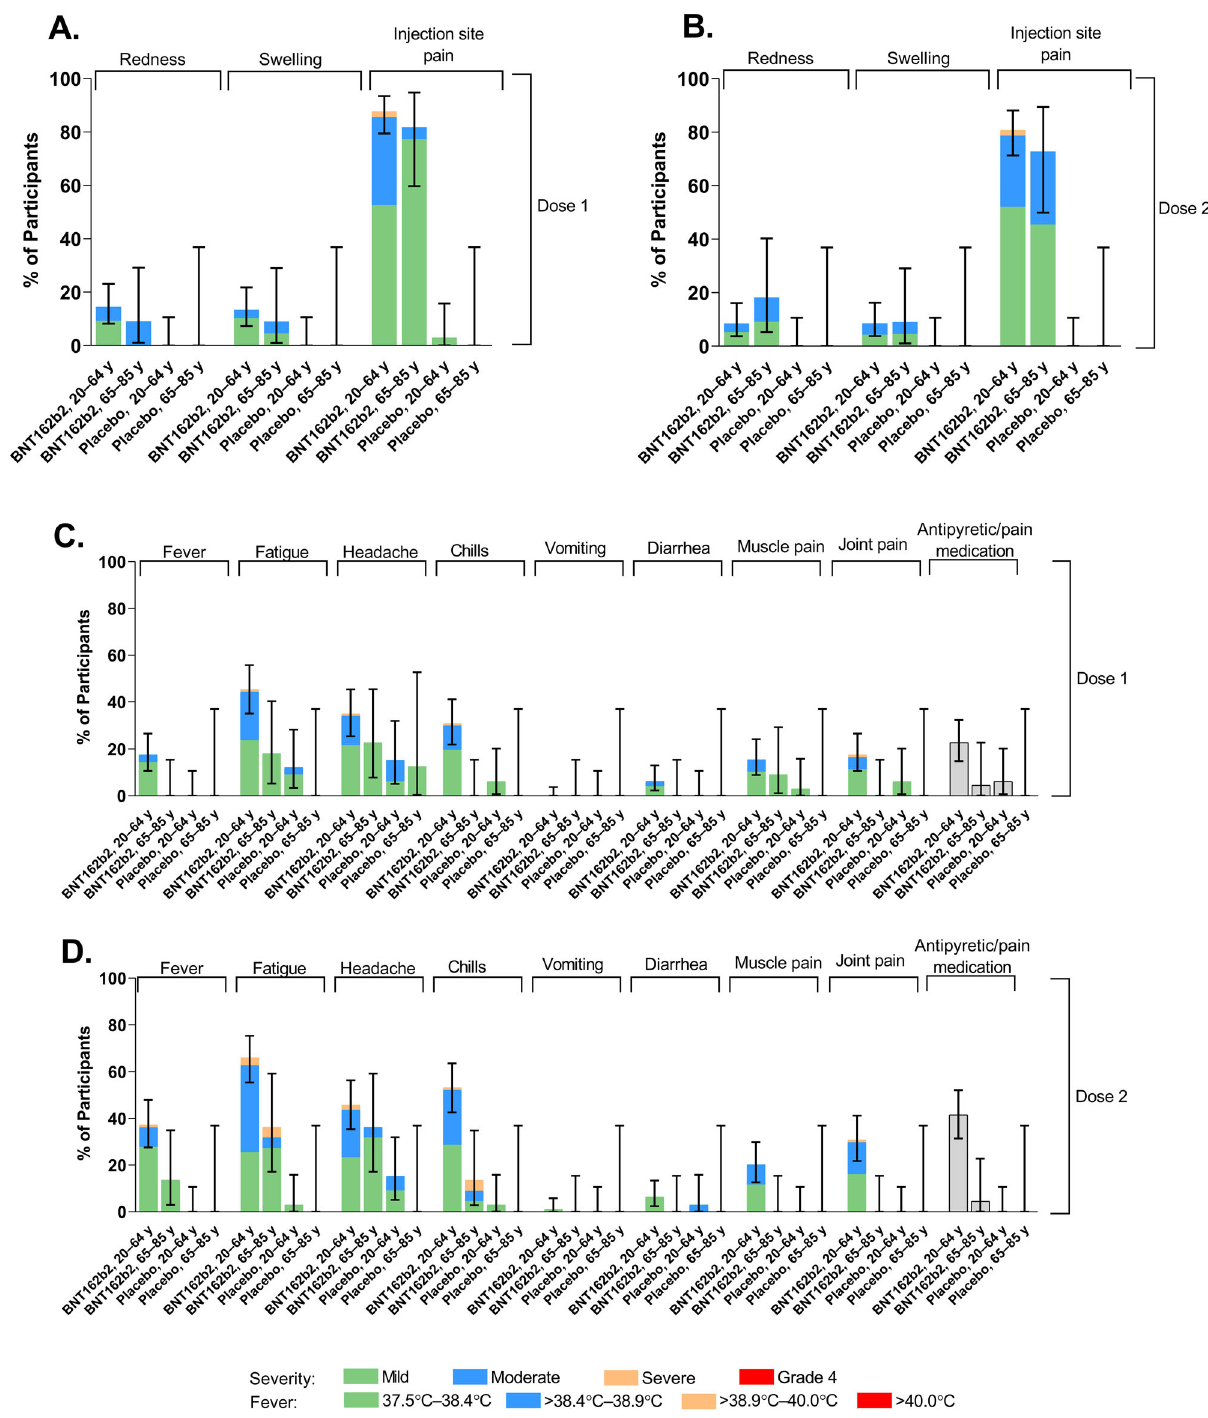
Fig. 2 Local reactions and systemic events reported within 7 days after administration of BNT162b2 or placebo in participants 20 – 64 years of age and 65 – 85 years of age. A , B Local reactions after doses 1 and 2, respectively. C , D Systemic events after doses 1 and 2, respectively. Results are for the safety population (20 – 64 years of age: n = 97 for BNT162b2, and n = 33 for placebo; 65 – 85 years of age: n = 22 for BNT162b2, and n = 8 for placebo). Pain at injection site was graded as mild (does not interfere with activity), moderate (interferes with activity), severe (prevents daily activity), or grade 4 (led to emergency department visit or hospitalization). Redness and swelling were graded as mild (>2.0 – 5.0 cm in diameter), moderate (>5.0 – 10.0 cm in diameter), severe (>10.0 cm in diameter), or grade 4 (necrosis or exfoliative dermatitis for redness and necrosis for swelling). Fever categories are shown in the key. Fatigue, headache, chills, and new or worsened muscle or joint pain were graded as mild (does not interfere with activity), moderate (some interference with activity), or severe (prevents daily activity). Vomiting was graded as mild (1 – 2 times in 24 h), moderate (>2 times in 24 h), or severe (requires intravenous hydration), and diarrhea as mild (2 – 3 loose stools in 24 h), moderate (4 – 5 loose stools in 24 h) or severe ( ≥ 6 loose stools in 24 h). Grade 4 for all systemic events indicated an emergency department visit or hospitalization. No participant experienced a grade 4 local reaction or systemic event. Data are presented as percentages with associated 95% CIs shown as error bars for the percentage of participants experiencing any